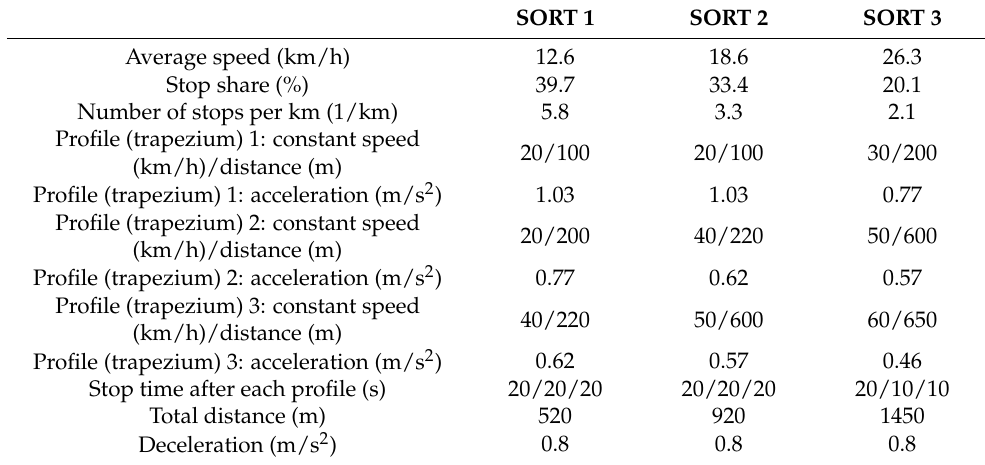
Table 6. Characteristics of SORT driving cycles.